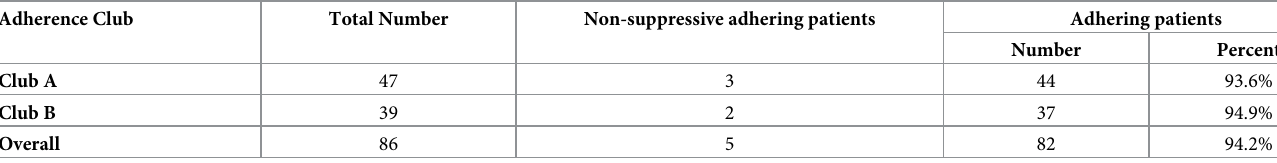
Table 5. Population level adherence rates of two adherence clubs in Facility X. Adherence